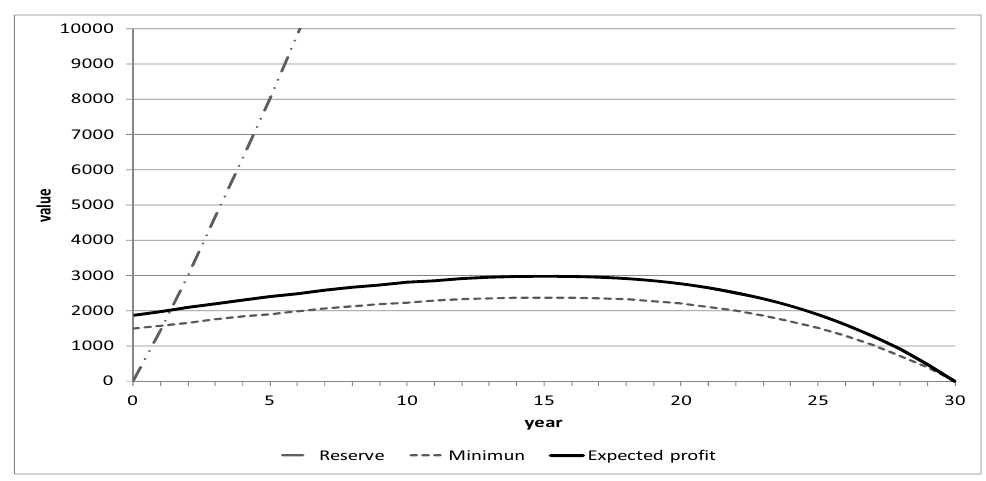
(cid:5) U and of the generation full t